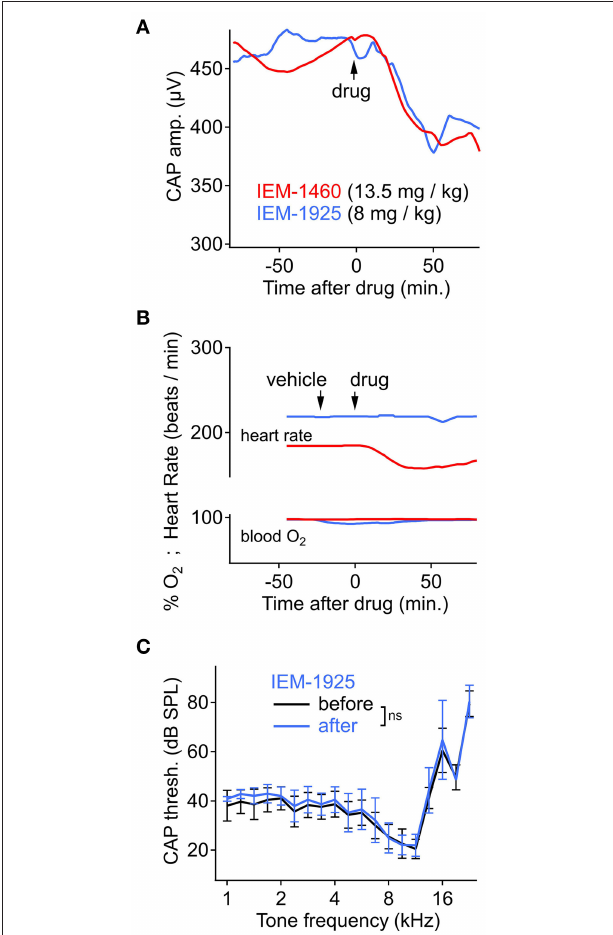
FIGURE 6 | Cochlear and cardiopulmonary physiology during systemic IEM-1460 or IEM-1925. (A) CAP amplitude over time, showing significant reduction after intraperitoneal (IP) injection of drug ( p < 0.001, Wilcoxon, N = 4). Stimuli were 8kHz tone bursts at 90 dB SPL. N = 4 animals per compound. (B) Heart rate and blood oxygen level before and after IP injection of drug or vehicle control in an exemplary experiment where heart rate was temporarily reduced by 15% ( p < 0.001, Wilcoxon, N = 4) following IP injection of 13.5 mg/kg IEM-1460 (red trace). (C) CAP threshold as a function of cochlear frequency was not significantly different after systemic injection of IEM-1925 ( p > 0.100 across all tested frequencies, Mann-Whitney U , N =